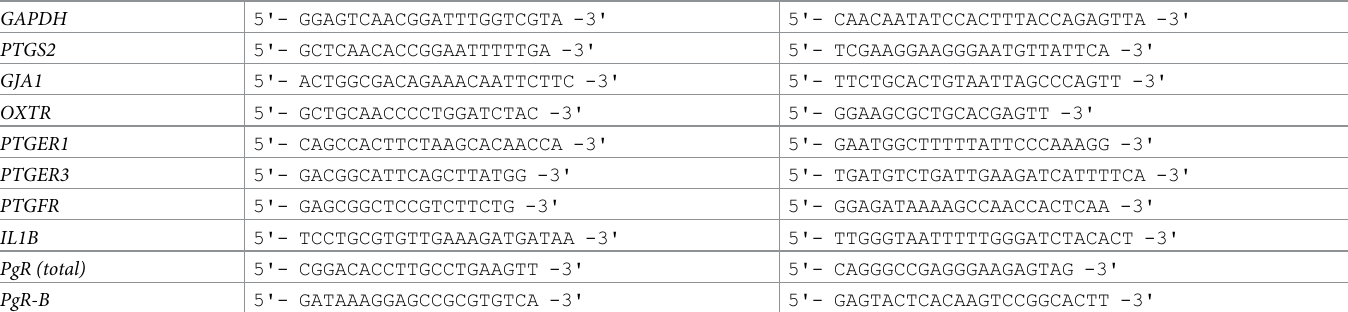
Table 1. Primer sequences used for quantitative RT-PCR.